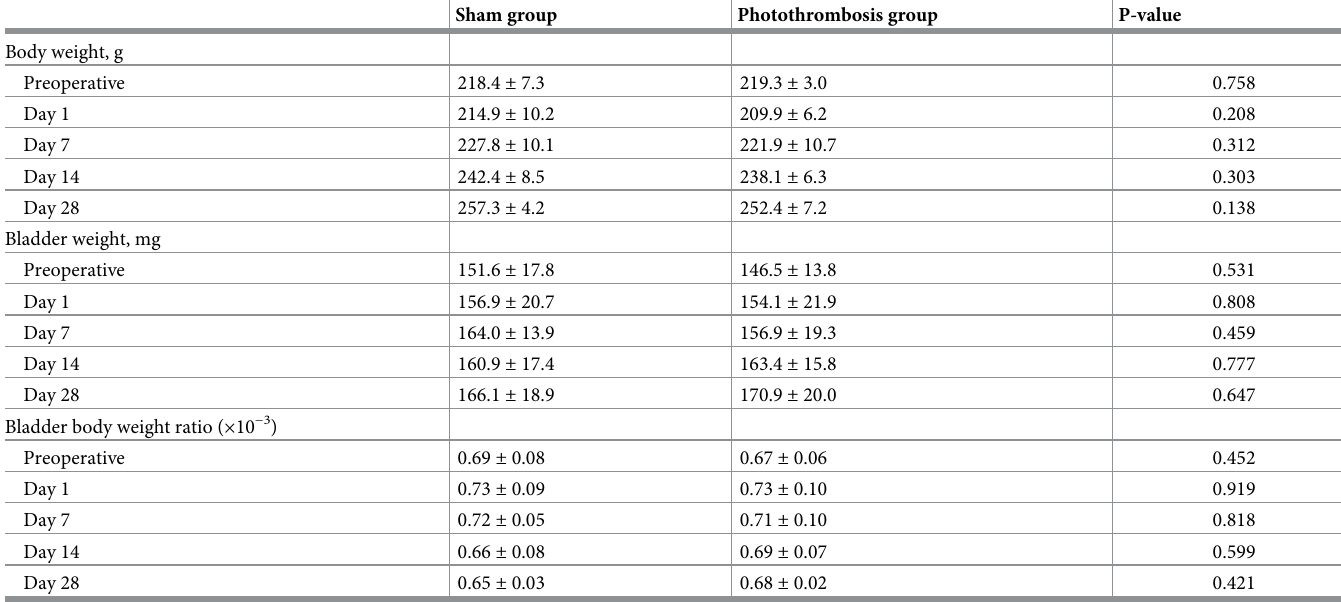
Table 1. Body and bladder weights in the different groups. Sham group Photothrombosis group